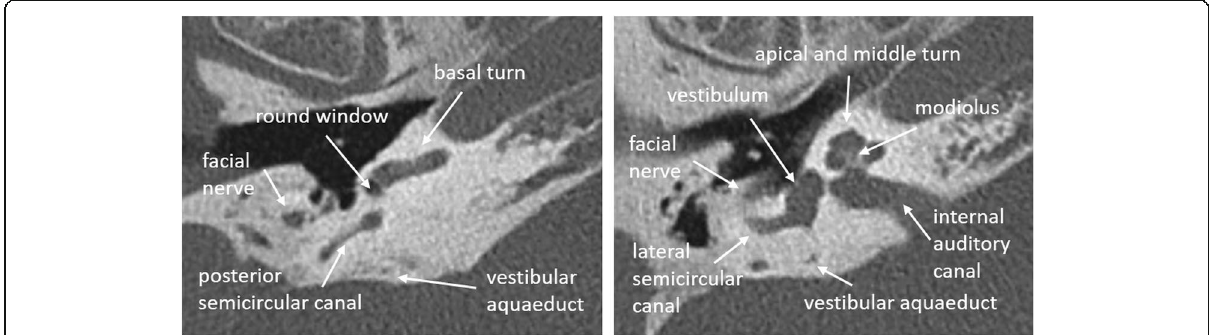
Fig. 1 HRCT axial images of normal cochlear anatomy in a 74-year-old man